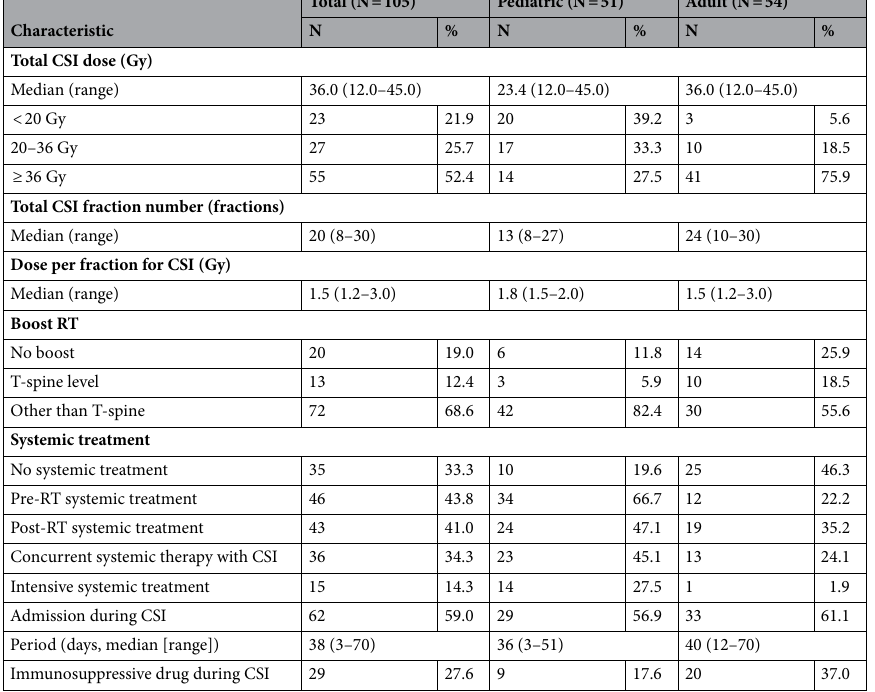
Table 2. Treatment characteristics of total patients and patients categorized by age of 20. CSI, craniospinal irradiation; Gy, gray; RT,